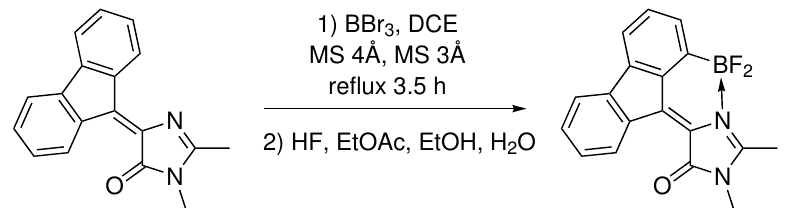
Scheme 2. Synthesis of